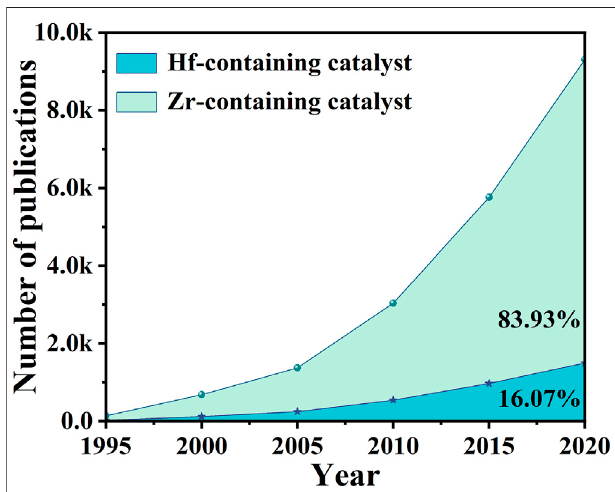
FIGURE 1 | Comparison of the number of publications on Zr-containing catalysts and Hf-containing catalysts. Source: web of science (a search carried out in November